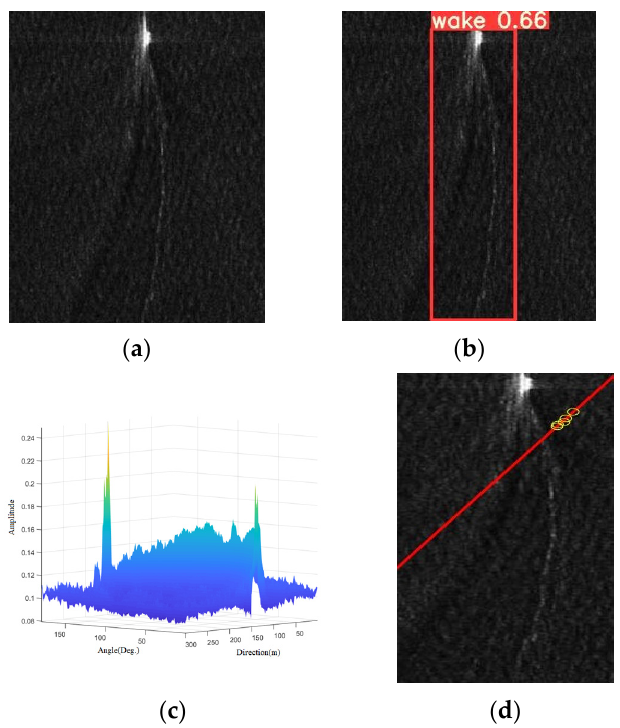
Figure 17. The comparison diagram of the nonlinear wake detection result: ( a ) curvilinear wake; ( b ) result of YOLOv5 detection; ( c ) result in the Radon transform domain; and ( d ) inversion result of the local Radon transform based on several most obvious peaks in ( c ).